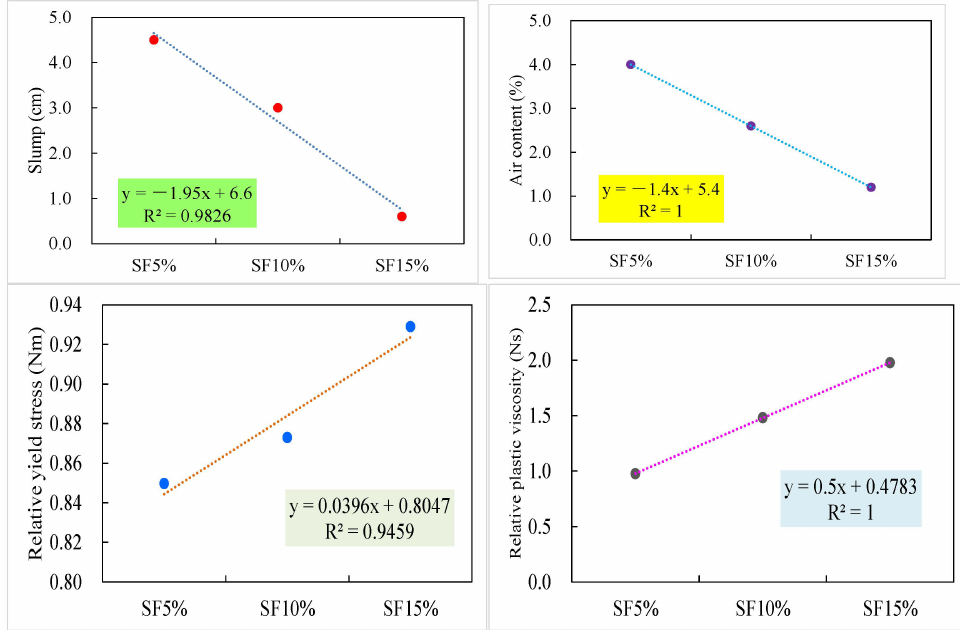
Figure 16. Effect of silica fume on slump, air content, relative yield stress, and